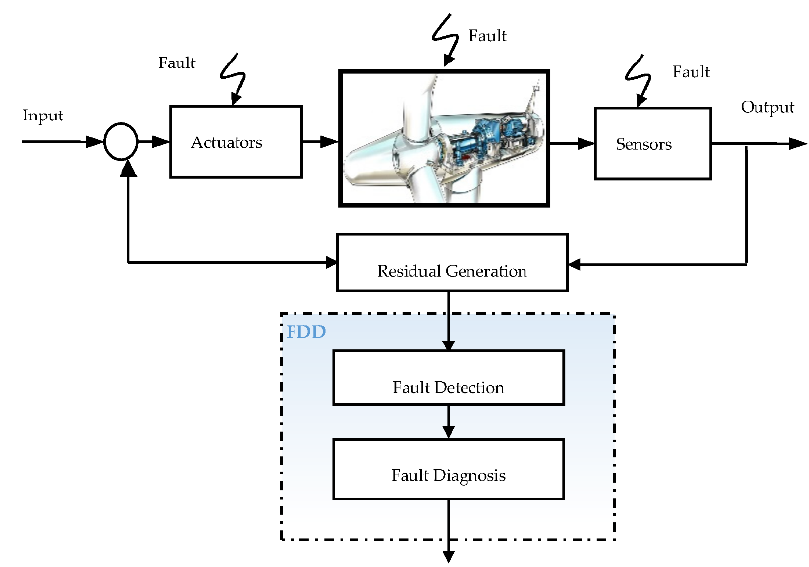
Figure 2. General architecture of an FDD module.